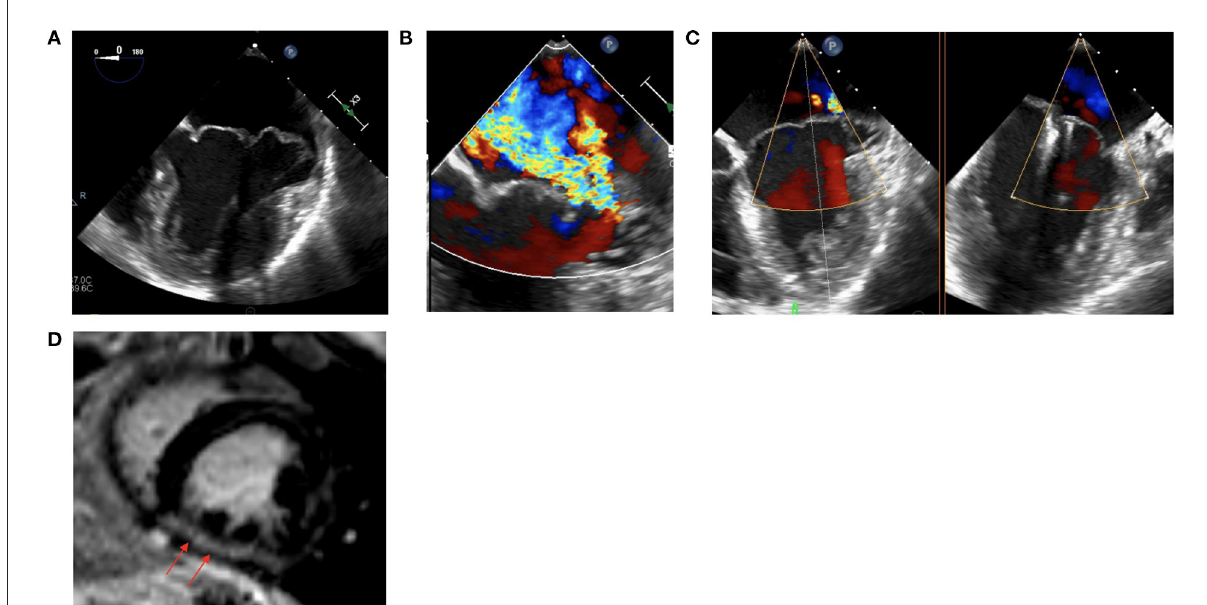
FIGURE2 (A) Intraprocedural TEE showing a myxomatous MV with bileaflet prolapse and MAD. (B) Intraprocedural TEE showing severe MR. (C) Status post placement of two MitraClips with improved MR. (D) CMR demonstrating mid-inferior wall